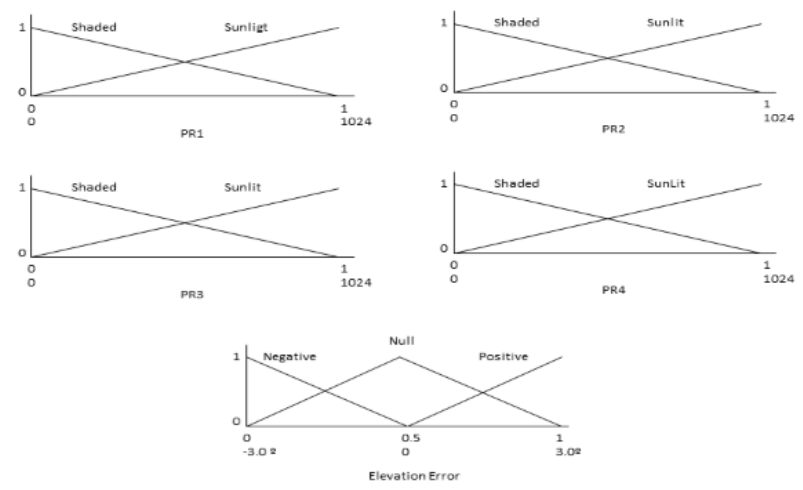
Figure 5. Fuzzy sets defined in input (PRs) and output variables (elevation error).